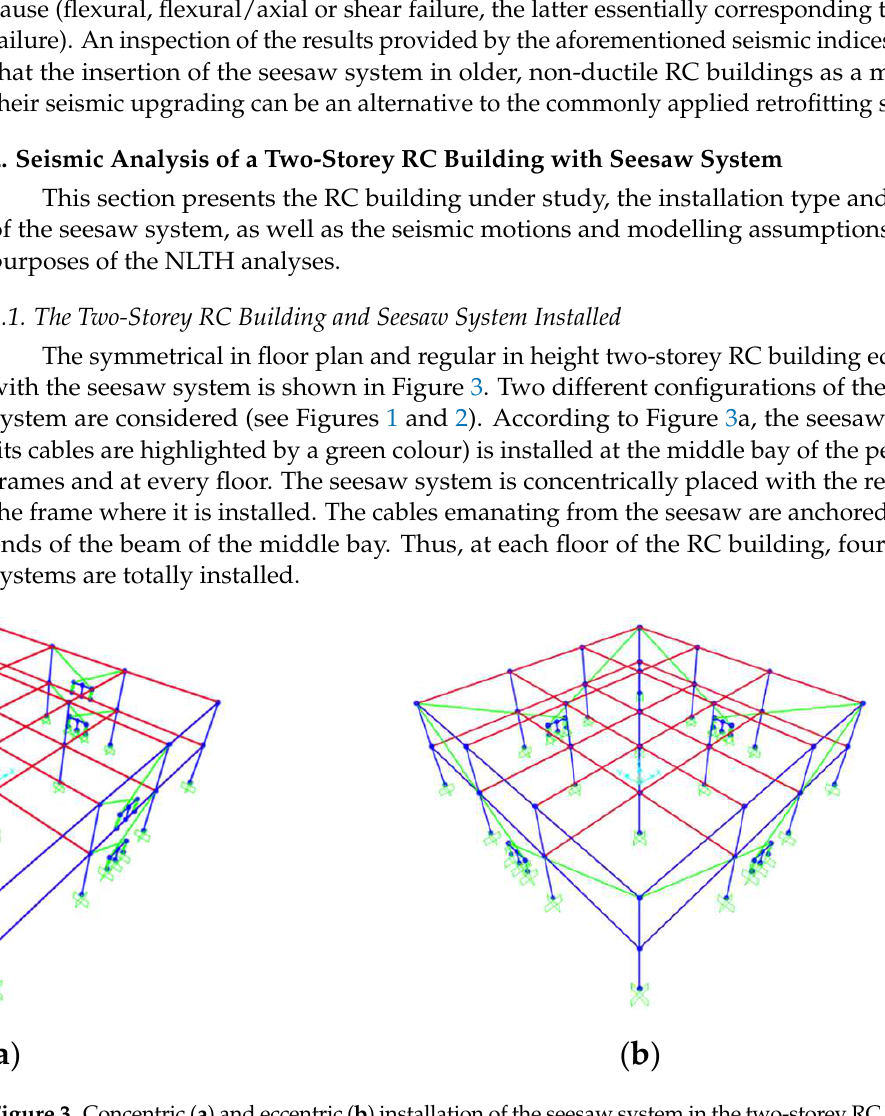
Figure 3. Concentric ( a ) and eccentric ( b ) installation of the seesaw system in the two-storey RC building.